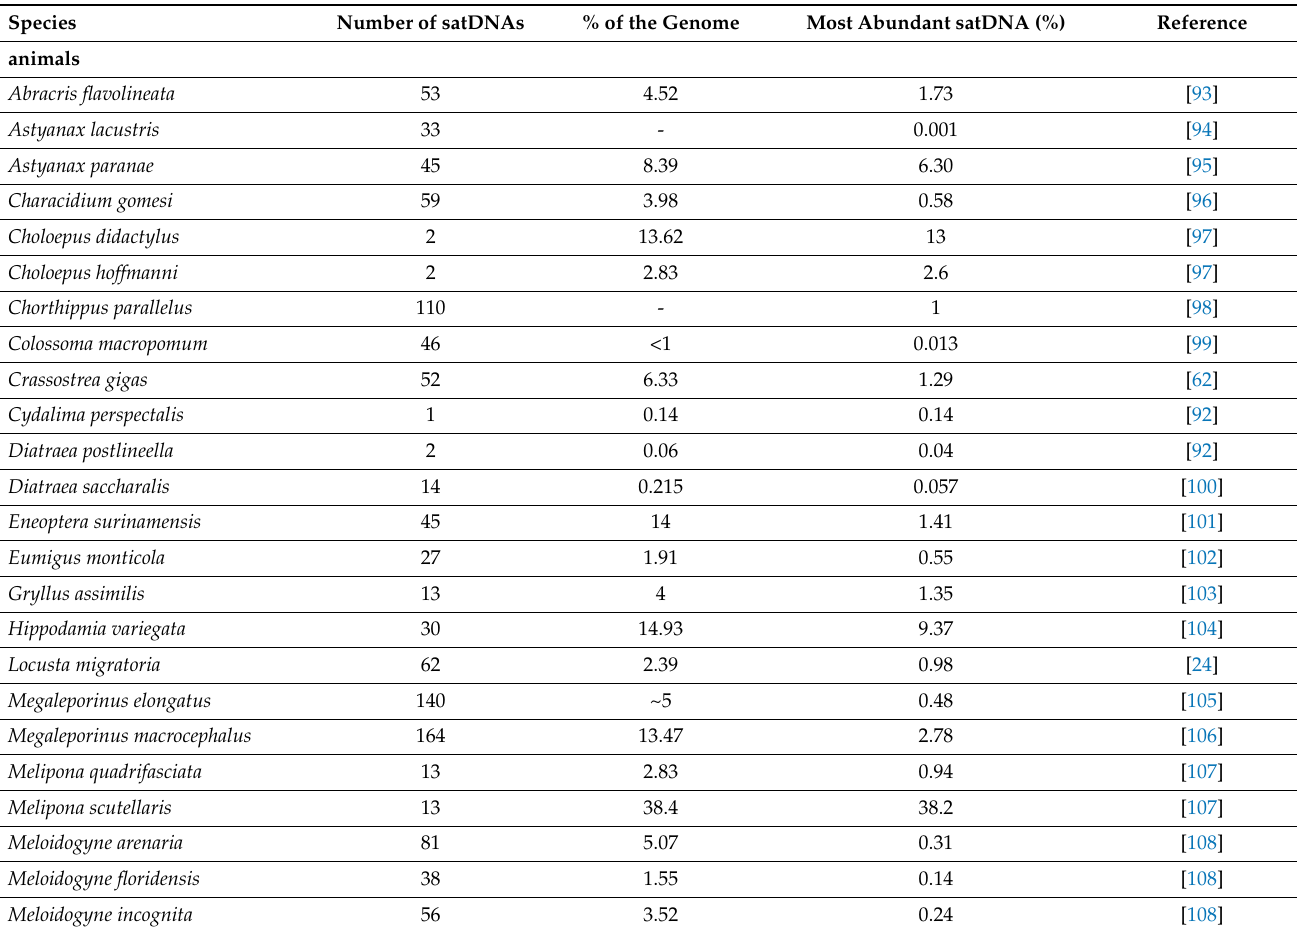
Table 1. Examples of diversity in number and genome abundances of satDNAs across a spectrum of animal and plant